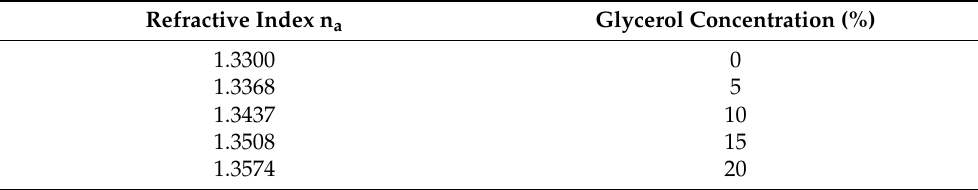
Table 1. The refractive index for the glycerol solution in